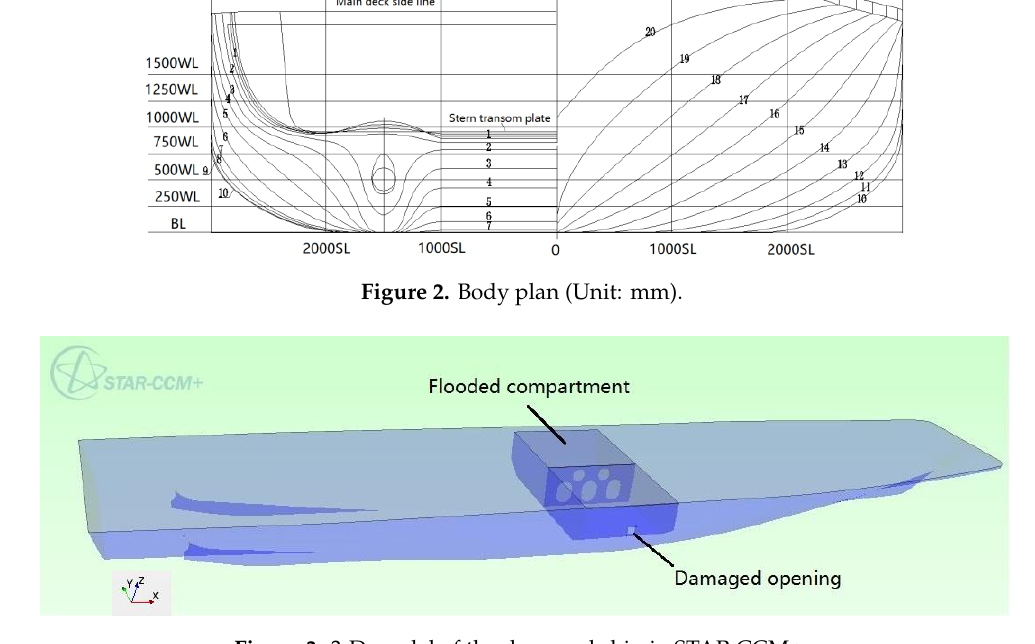
Figure 3. 3-D model of the damaged ship in STAR CCM+. Table 2. Main particulars of the damaged ship.